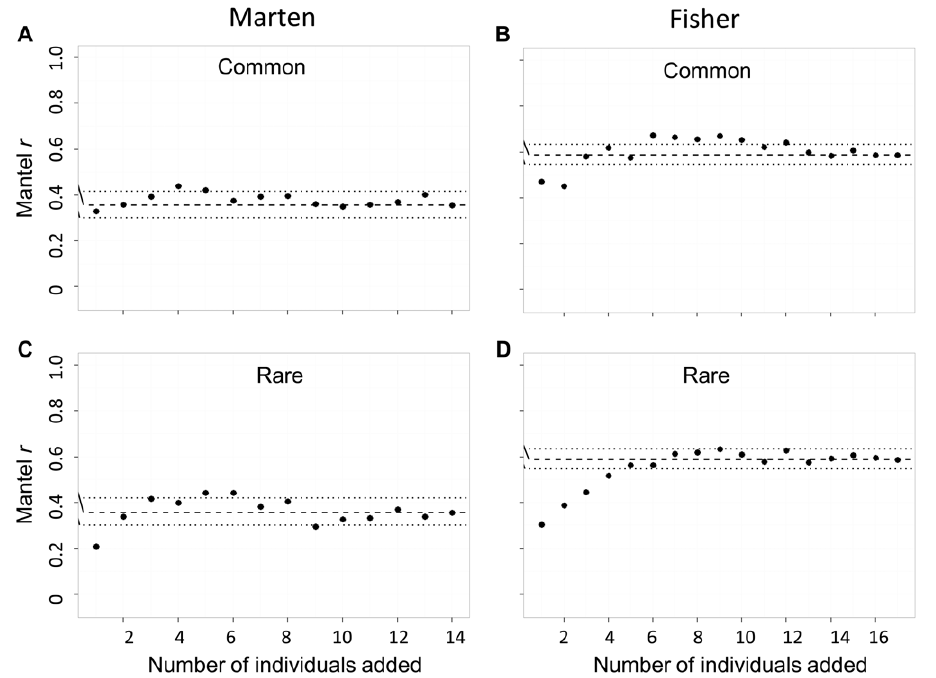
Figure 8. The effect of under-sampled sites on Mantel r statistics testing isolation by distance. Each iteration represents the addition of one individual to each site in the network, such that individuals have common genotypes (panels a and b) or rare genotypes (panels c and d), for both the marten ( Martes americana ) and fisher ( M. pennanti ) datasets. The dashed line is the Mantel r (95% CI) statistic for the full dataset. Isolation by distance is the relationship between cGD and log Euclidean distance.